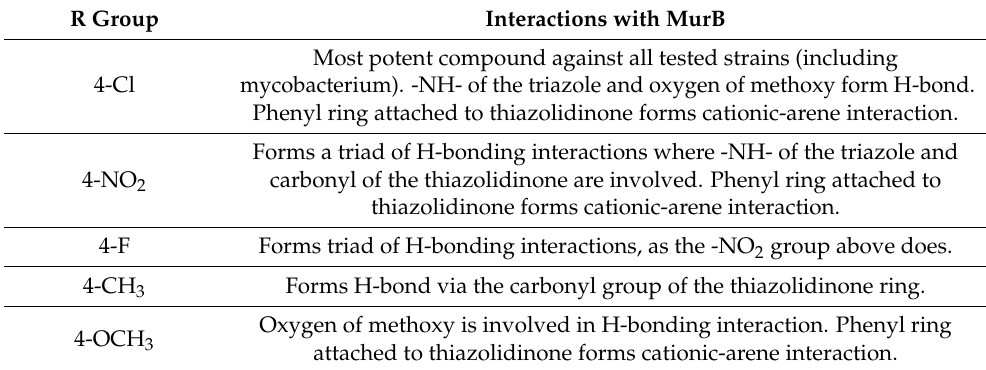
Table 1. Interactions of most active derivatives of the 1,2,4-triazole-based thizaolidinone series with the MurB enzyme of S. aureus . R Group Interactions with MurB Most potent compound against all tested strains (including 4-Cl mycobacterium). -NH- of the triazole and oxygen of methoxy form H-bond. Phenyl ring attached to thiazolidinone forms cationic-arene interaction. Forms a triad of H-bonding interactions where -NH- of the triazole and 4-NO 2 carbonyl of the thiazolidinone are involved. Phenyl ring attached to thiazolidinone forms cationic-arene interaction. 4-F Forms triad of H-bonding interactions, as the -NO 2 group above does. 4-CH 3 Forms H-bond via the carbonyl group of the thiazolidinone ring. Oxygen of methoxy is involved in H-bonding interaction. Phenyl ring 4-OCH 3 attached to thiazolidinone forms cationic-arene